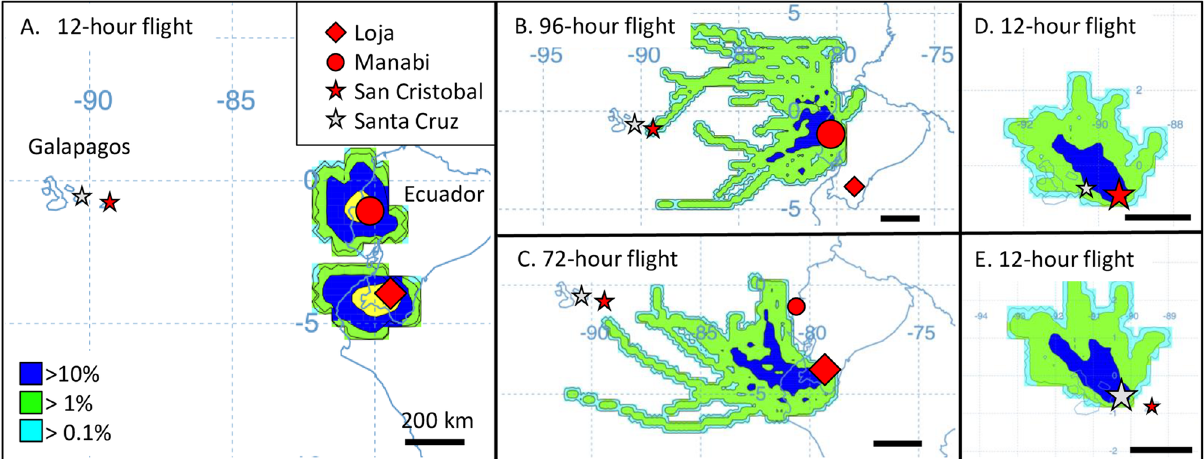
Figure 7. HYSPLIT forward projections of dispersions from locations in Ecuador based on 2019 air transport data for the month of June. Thirty projections of either 12-h, 72-h, or 96-h continuous flight durations were plotted. The frequency that a projected trajectory passed over a grid cell was summed and then normalized by the total number of trajectories to give the color-coded percentages. Relevant locations are identified by colored shapes, which when enlarged are origins for the HYSPLIT modeling. Maps were obtained using HYSPLIT modeling from the Air Resources Laboratory (ARL) READY web site run by NOAA (http:// ready. arl. noaa. gov/ HYSPL IT. php 49 . ( A ) HYSPLIT 12-h continuous flight projection originating from Loja (− 4.02, − 79.27) and Manabi (− 1.10, − 80.43) provinces in mainland Ecuador. ( B ) 96-h continuous flight projection from Manabi province. ( C ) 72-h continuous flight projection from Loja Province. ( D ) 12-h projection from San Cristóbal island (− 0.87, − 89.43). ( E ) 12-h projection from Santa Cruz island (− 0.59, −